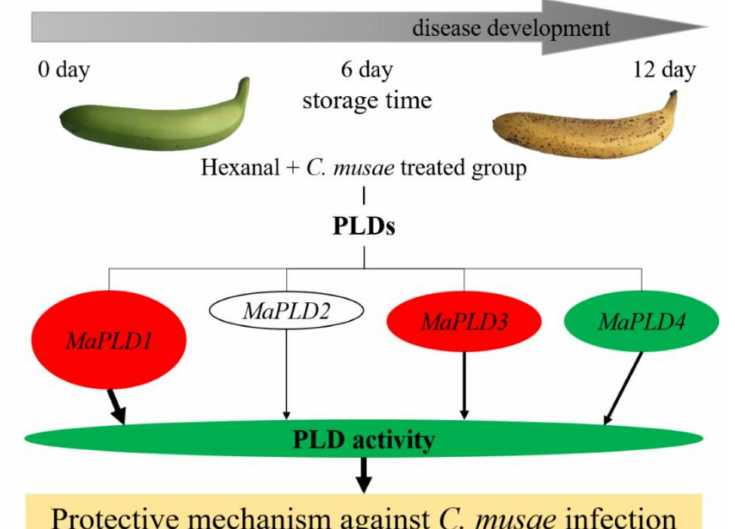
Figure 6. Schematic integration of the changes in PLDs gene expression and activity induced by hexanal in banana fruits inoculated with C. musae during storage. The effect of hexanal on PLDs gene expression is indicated by shape size: The bigger the size, the more marked the changes. The red color indicated the gene expression was activated, and the green color indicated the gene expression or activity was inhibited. The thicker black arrows indicated more involvement of these genes in banana fruit response to C. musae